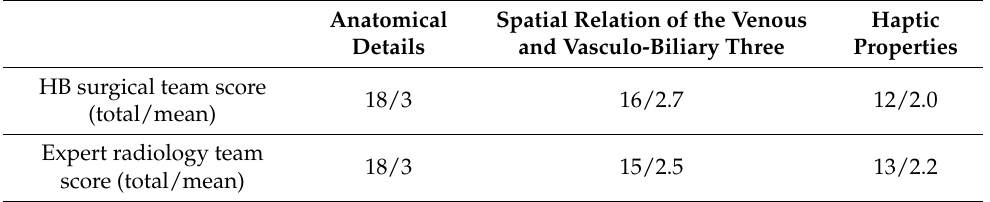
Table 1. Evaluation score by the expert team composed of six HB surgeons and six radiologists. Anatomical Details